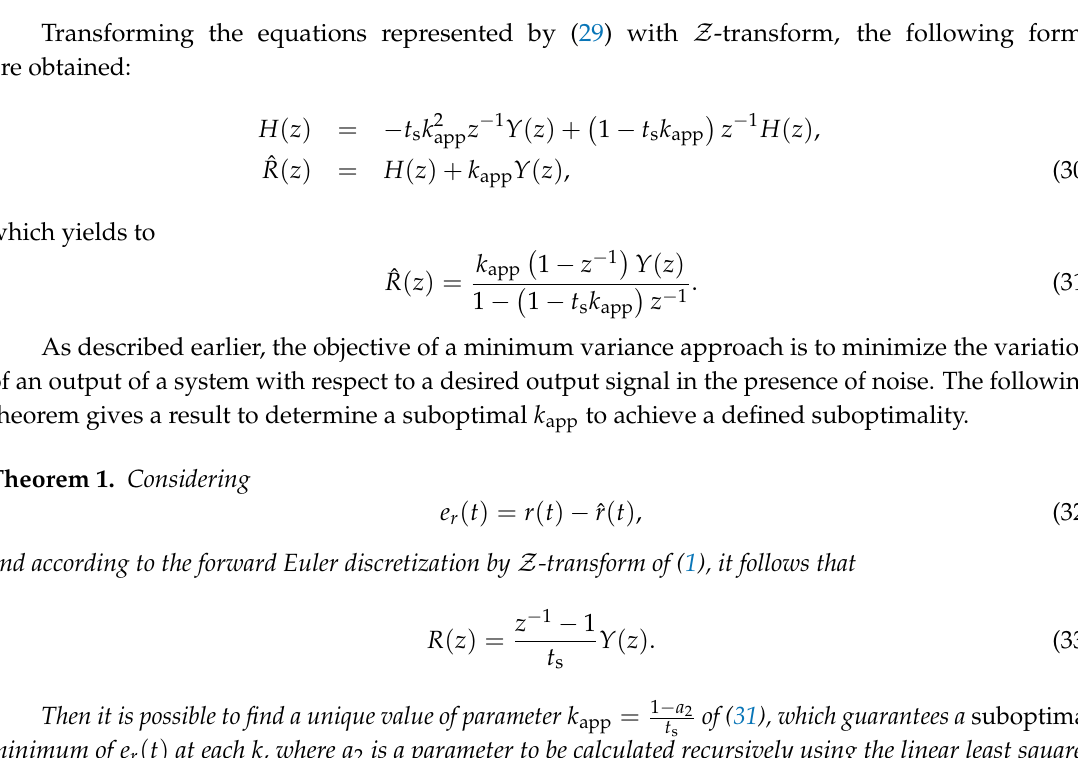
Figure 1. Graphical representation of the algorithm structure and its components. LSM: linear least squares